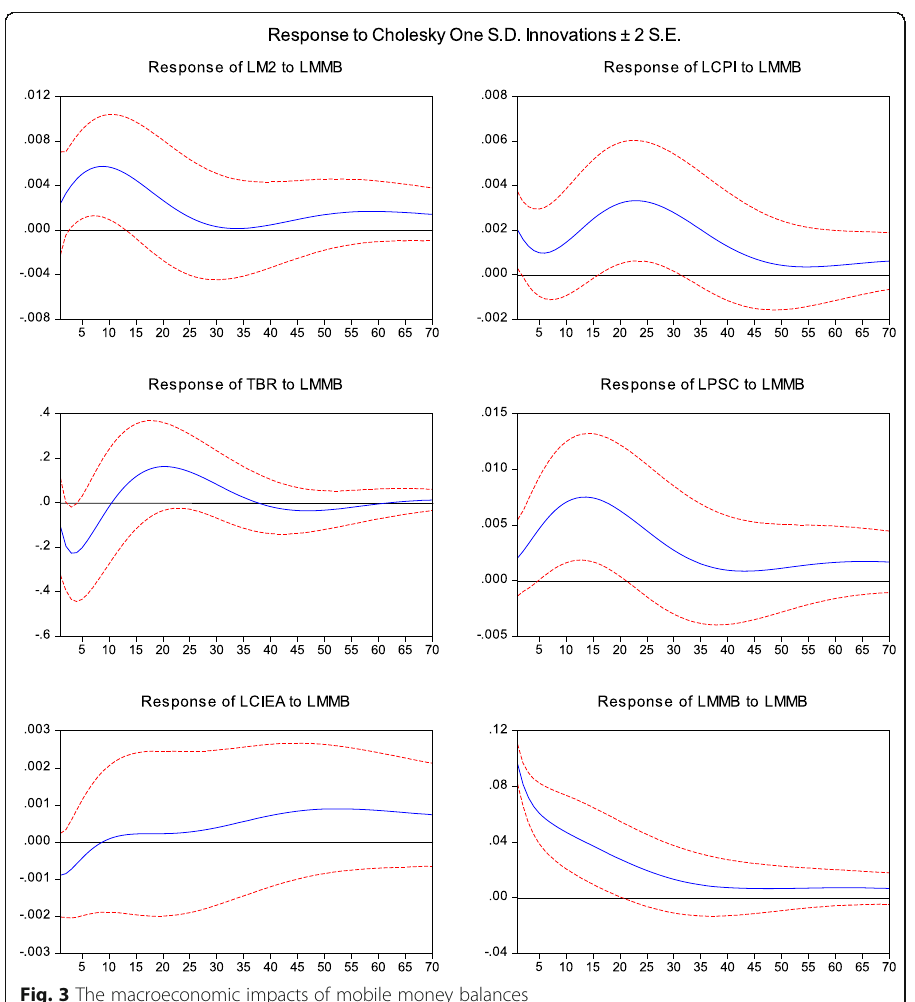
Fig. 3 The macroeconomic impacts of mobile money